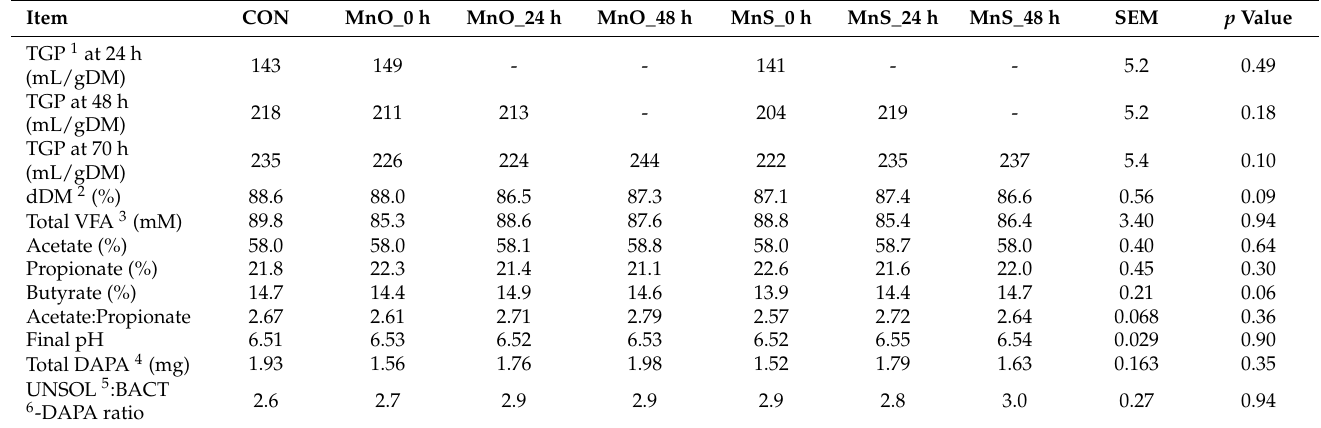
Table 3. Influence of inorganic Mn source and addition time on fermentation